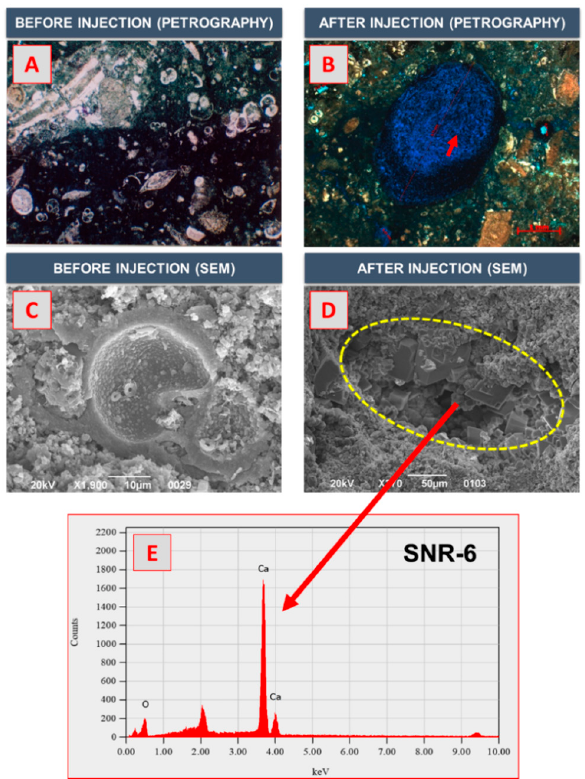
Figure 10. Results of SEM–EDX and thin-section analyses of SNR-6.